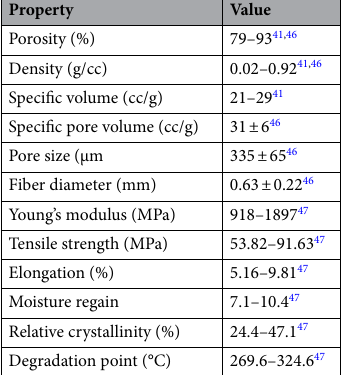
Table 1. Physico-chemical properties of Luffa